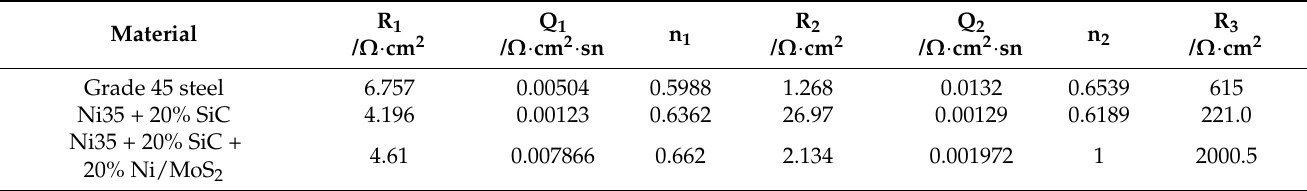
Table 4. Equivalent circuit diagram fitting data table.